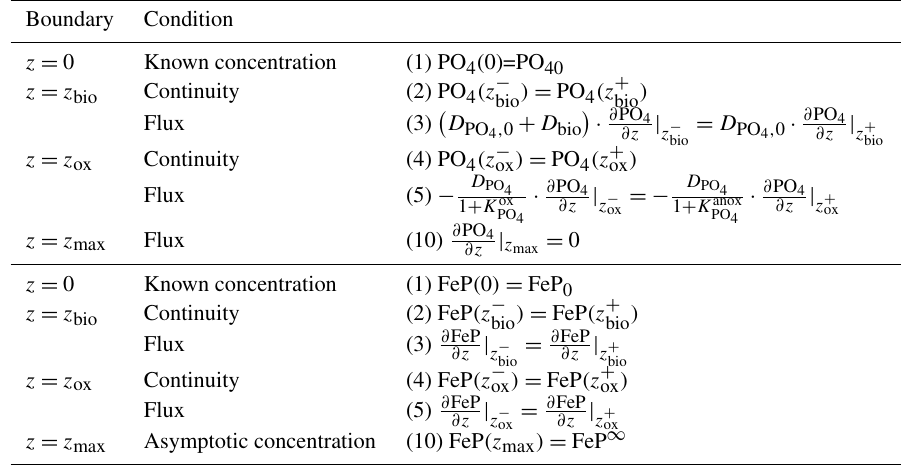
Table 6. Boundary conditions for phosphate and Fe-bound P (FeP). For the boundaries we define z − __ = lim h → 0 (z __ − h) and z + __ = lim h → 0 (z __ + h) .